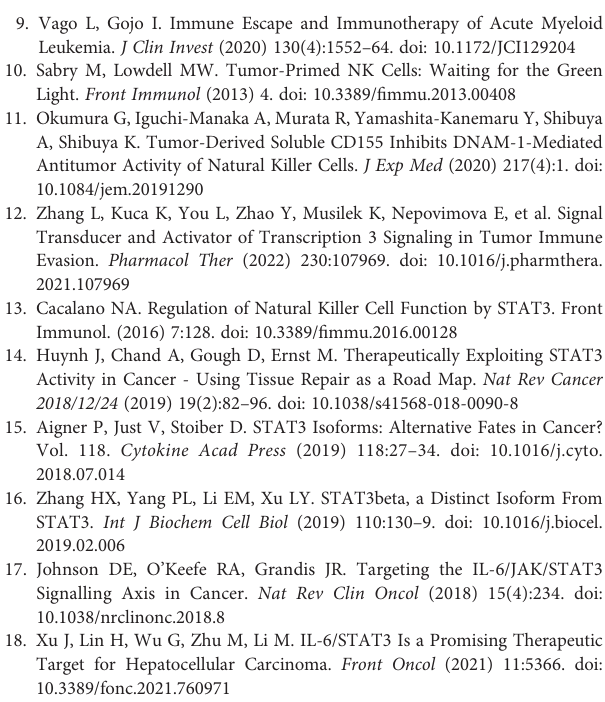
in vivo with different cytokines present in the tumor